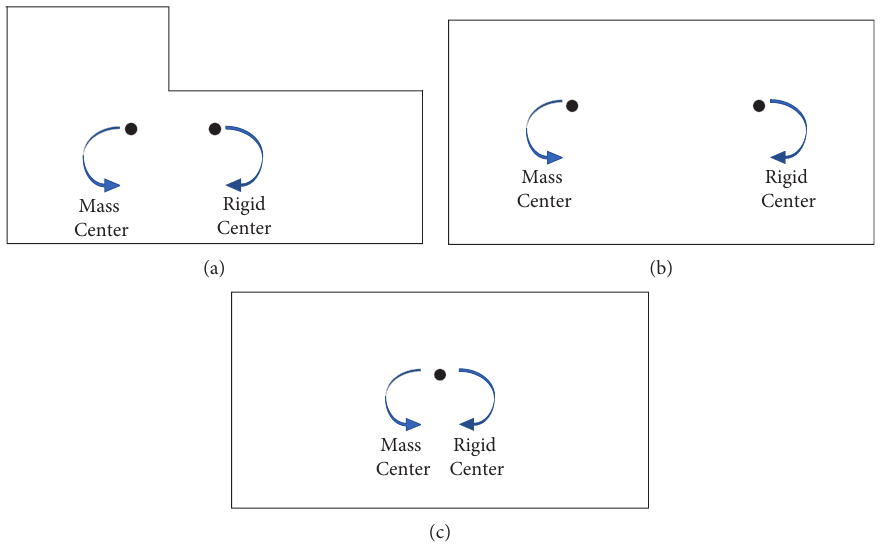
Figure 4: Plan view of structure with different geometric shapes. (a) Plan view of L-shaped structure (Structure A). (b) Plan view of plan- asymmetric rectangle structure (Structures B). (c) Plan view of plan-symmetric rectangle structure (Structure